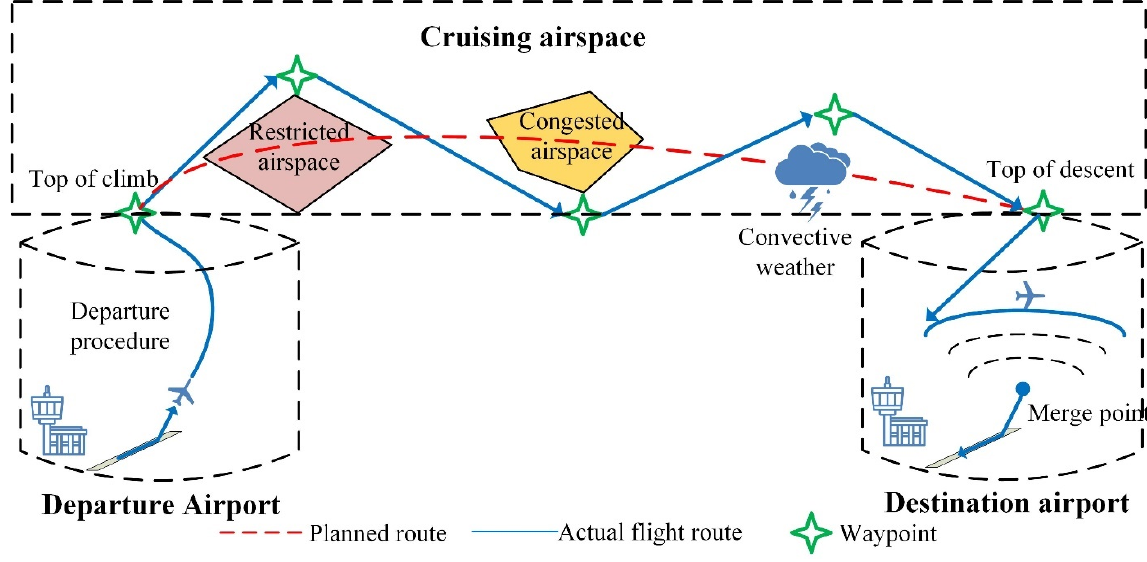
Figure 1. Schematic diagram of an aircraft in different stages of flight.